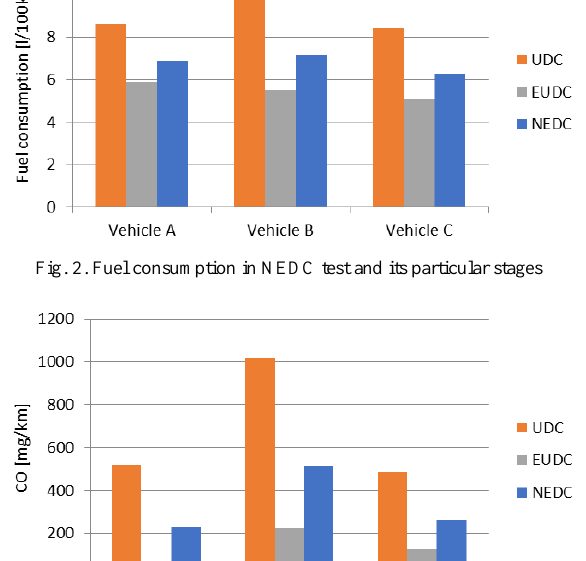
Fig. 6. Particle emissions in NEDC test and its particular stages